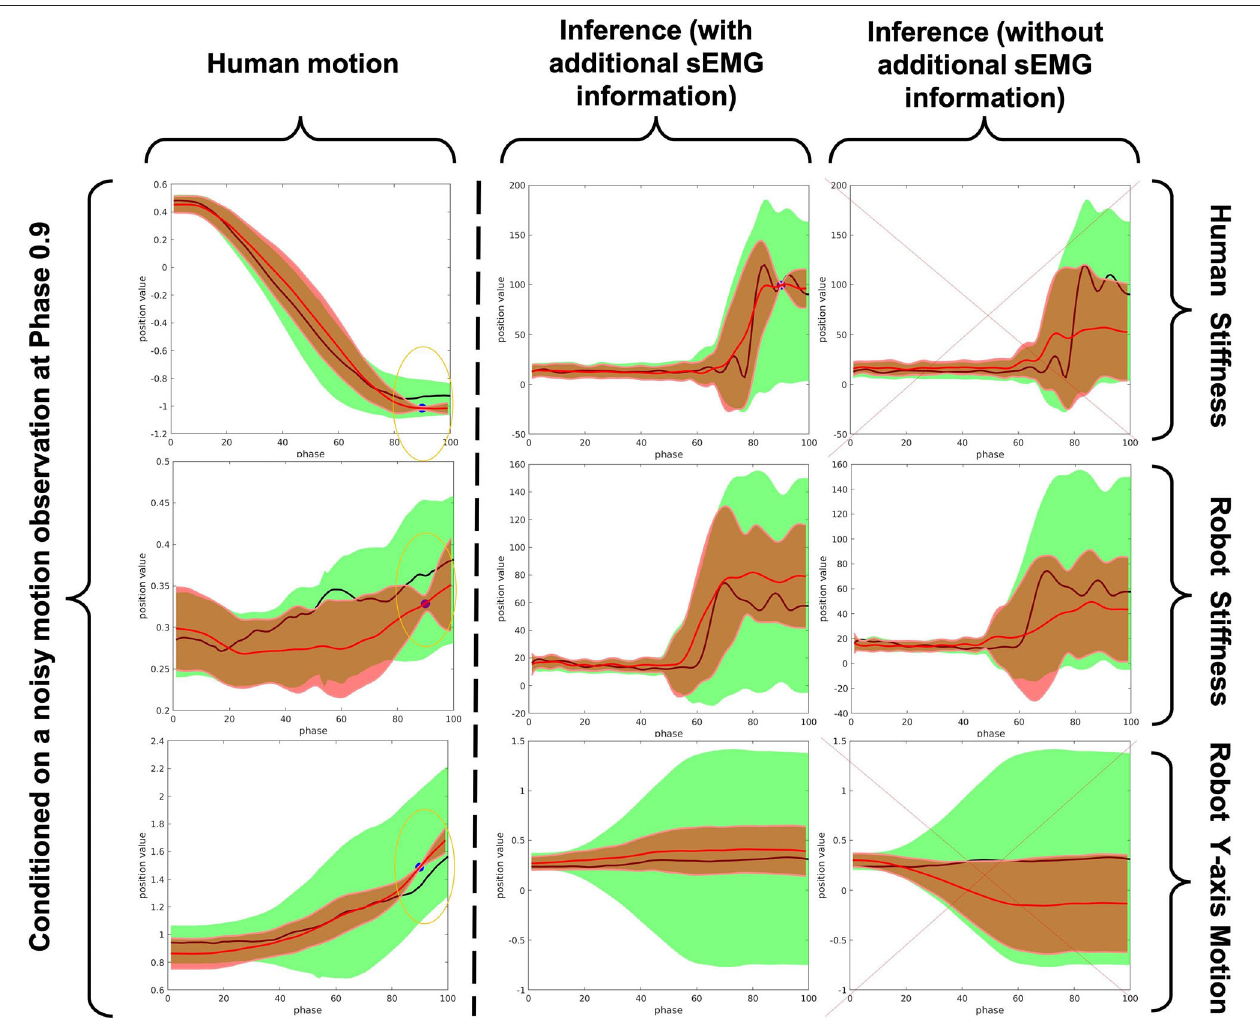
FIGURE 13 | A comparison between the inference results of with and without using sEMG signal when conditioned on a motion observation with a reasonable amount of noise (red trajectory: inference of mean trajectory/black trajectory: human demonstrated ground truth/green area: 2- σ region of covariance of the pre-trained ProMP/red area: 2- σ region of covariance of the modulated ProMP/blue point: noisy